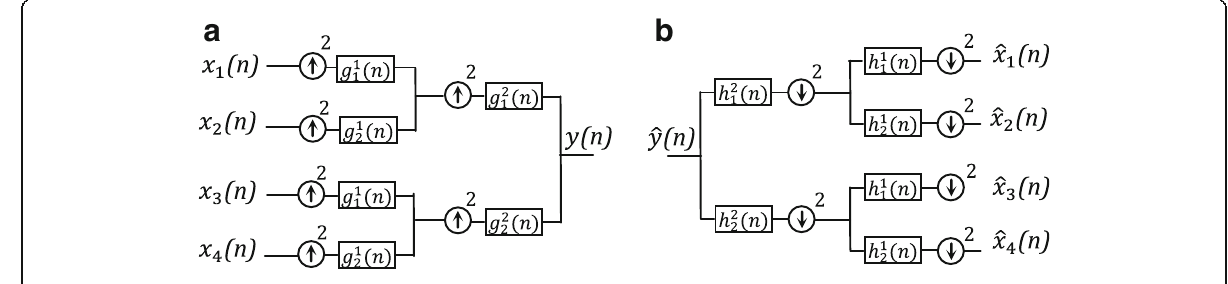
Fig. 3 Four-band tree-structured filter bank. a Synthesis part. b Analysis part